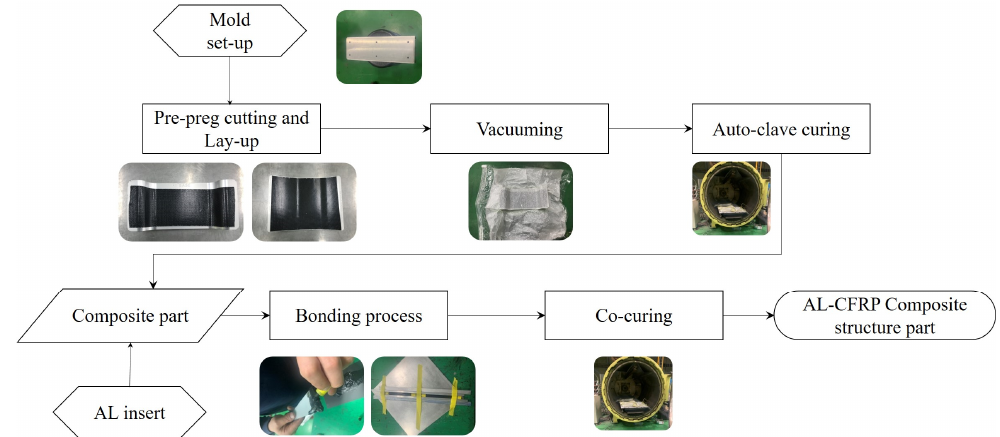
Figure 11. Manufacturing process of composite structure.